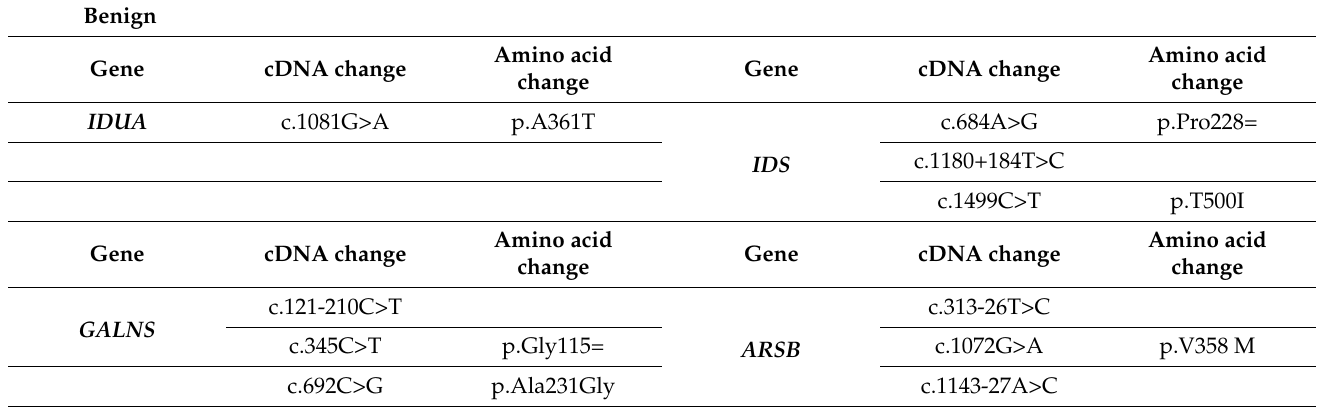
Table 4. Benign (likely benign) variants of MPS genes, i.e., IDUA , IDS , GALNS , and ARSB defined by the ACMG